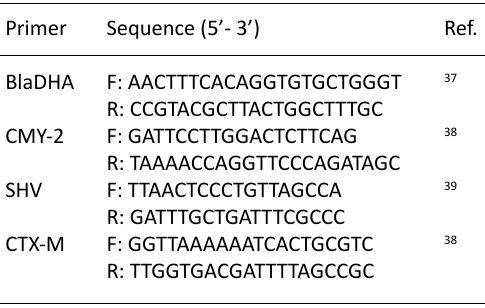
Table 2 . Gene-specific primers for ESBL detection Primer Sequence (5’- 3’)